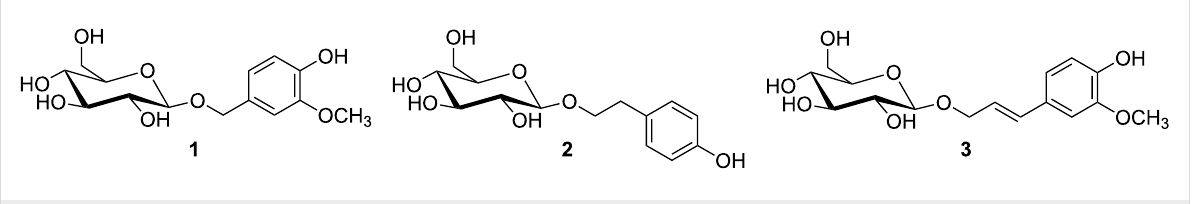
Figure 1: Structures of vanillyl β -D-glucoside ( 1 ), salidroside ( 2 ) and isoconiferin ( 3